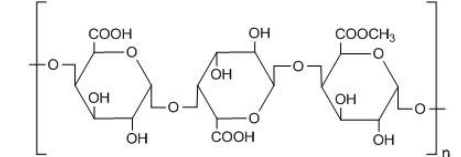
Figure 1. Chemical structure of